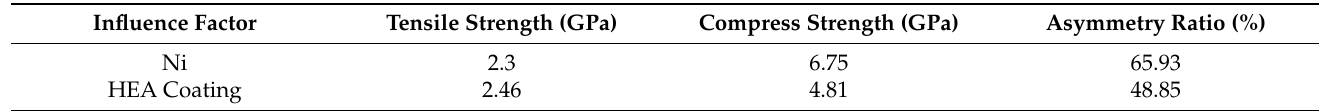
Figure 12. Dislocation analysis diagram obtained by tensile-compression of pure Ni and Ni rein- forced with the Fe 33 Ni 32 Cr 11 Co 11 Cu 13 HEAs coating at 300 K. ( a ) CSP, DXA and CAN at tensile (pure Ni) strain of 7.67%, 8.67% and 9.67%, respectively. ( b ) CSP, DXA and CAN at compressive (pure Ni)